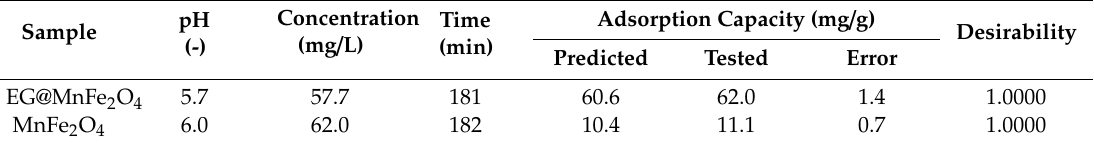
Table 6. Confirmation of experiment results.